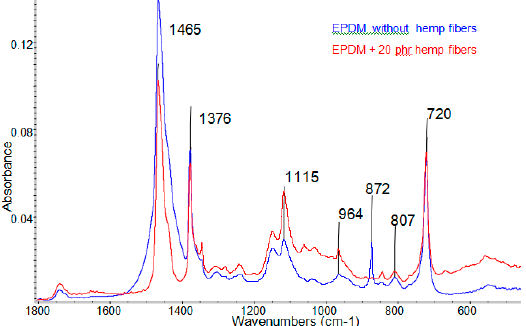
Figure 13. The infrared spectra for EPDM samples without hemp fibers and with 20 phr hemp fibers, irradiated with 150 kGy.